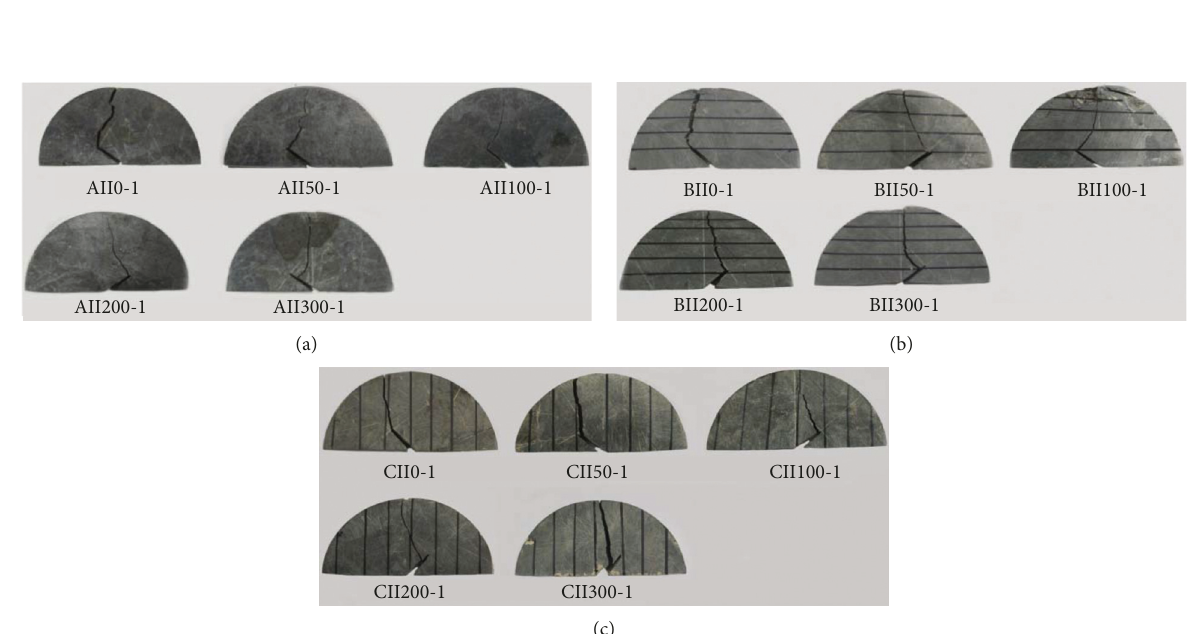
Figure 7: The propagation of crack in (a) Type A, (b) Type B, and (c) Type C SCB specimens for pure mode II with different degrees of